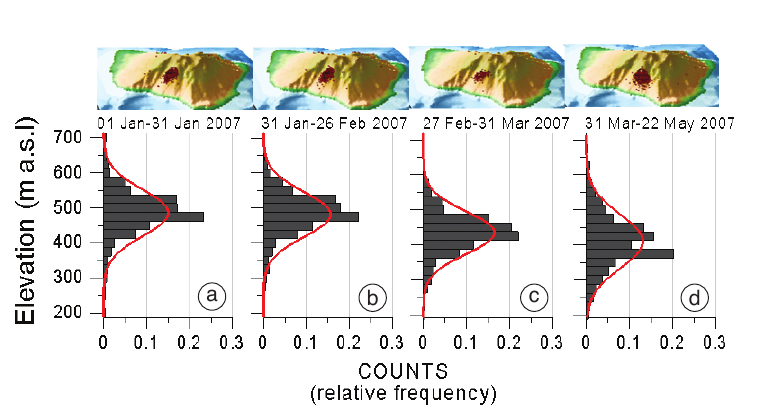
Fig. 6a-d. The VLP location and the histograms of the hypocentral elevation before and after the beginning of the effusive eruption (February 27, 2007). The elevation is expressed as meters above sea level. The temporal range is divided in four intervals: a) January 1-31; b) January 31-Februay 26; c) February 27-March 31; d) March 31-May 22. Note that there are no significant changes between the (a) and (b) periods (before the effusive phase), whereas a progressive elevation decrease is evident in (c) and (d) (after the beginning of the effusive